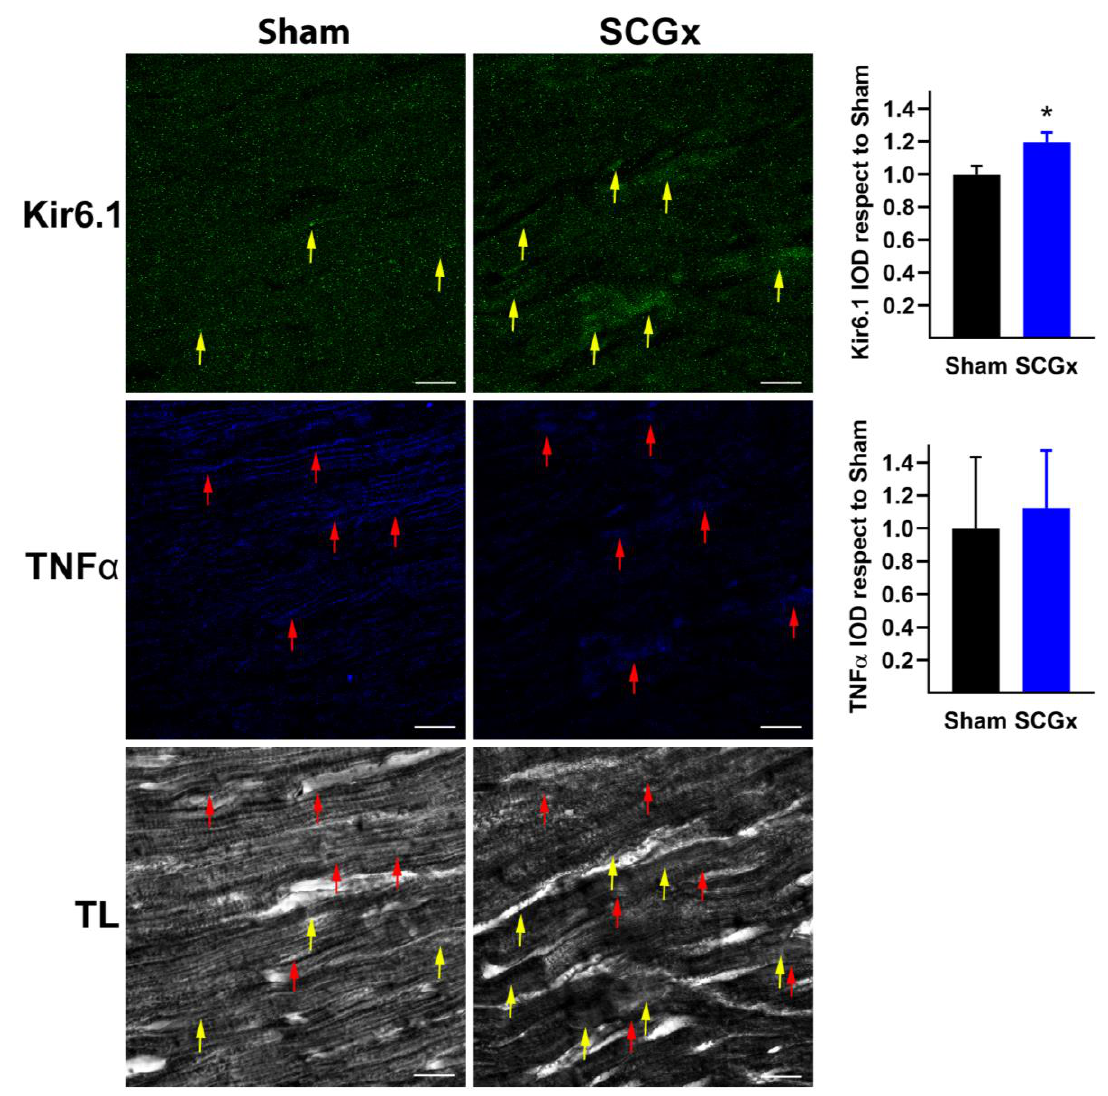
Figure 6. The pore-forming subunit (Kir6.1) of K ATP and tumor necrosis factor-alpha (TNFα) in SCGx rats. Kir6.1 increased in cardiomyocytes from ganglionectomized rats (yellow arrows). The levels of the inflammatory marker TNFα were low in ventricular samples of both groups (red arrows). Bars in the right-hand column indicate the mean integrated optical density (IOD) and SEM values relative to the level measured in the Sham group. The white scale bars in the lower right corners indicate 20 µM. In both groups, a total of 18 pictures were analyzed, six from three different hearts. * p < 0.05 vs. Sham by unpaired t-test with Welch’s correction.